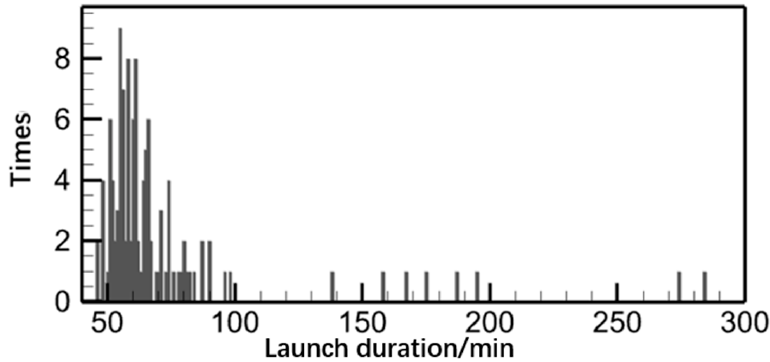
Figure 2. Unit startup time statistics.